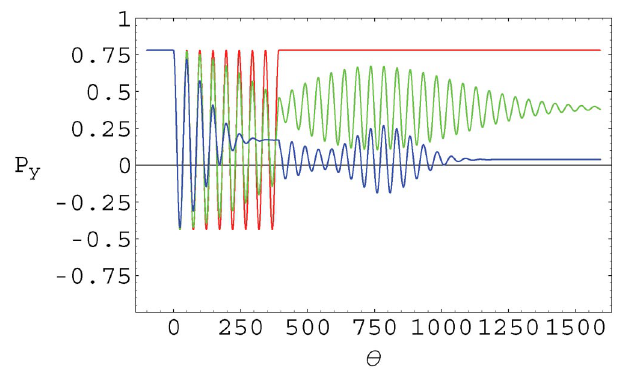
FIG. 2. (Color) Response of a polarized beam to a double-jump across a resonance. Three curves correspond to three different energy spreads of the